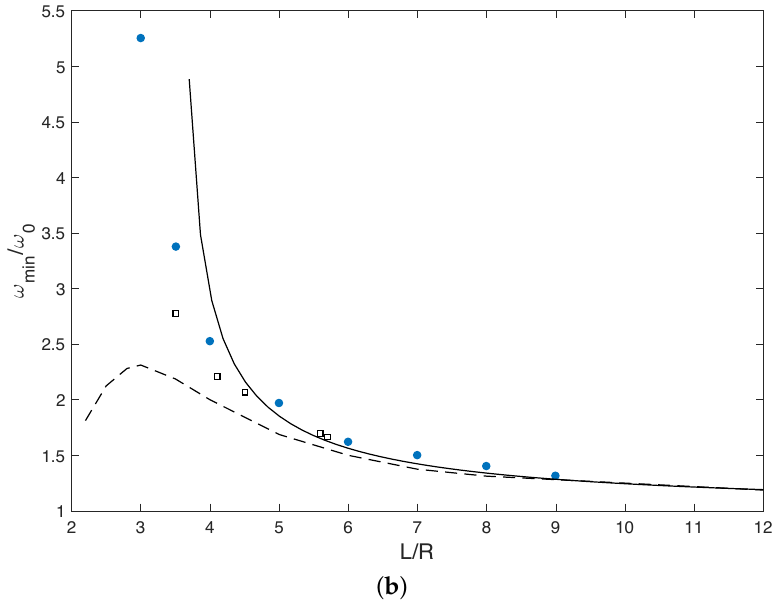
Figure 5. ( a ) Examples of transmission predictions by the dipole model taking into account the dipolar contribution (Equation (11)), in the cases of Sample 2 (circles) and simulation for L / R = 3 (crosses). In both cases, the model with the dipole (dashed lines) predicts a minimum of transmission at a frequency lower than what is measured or calculated. ( b ) Frequency of the minimum of transmission as a function of L / R , as found in simulations (full circles) and experiments (open squares) and as predicted by the monopole (solid line) and dipole (dashed line)